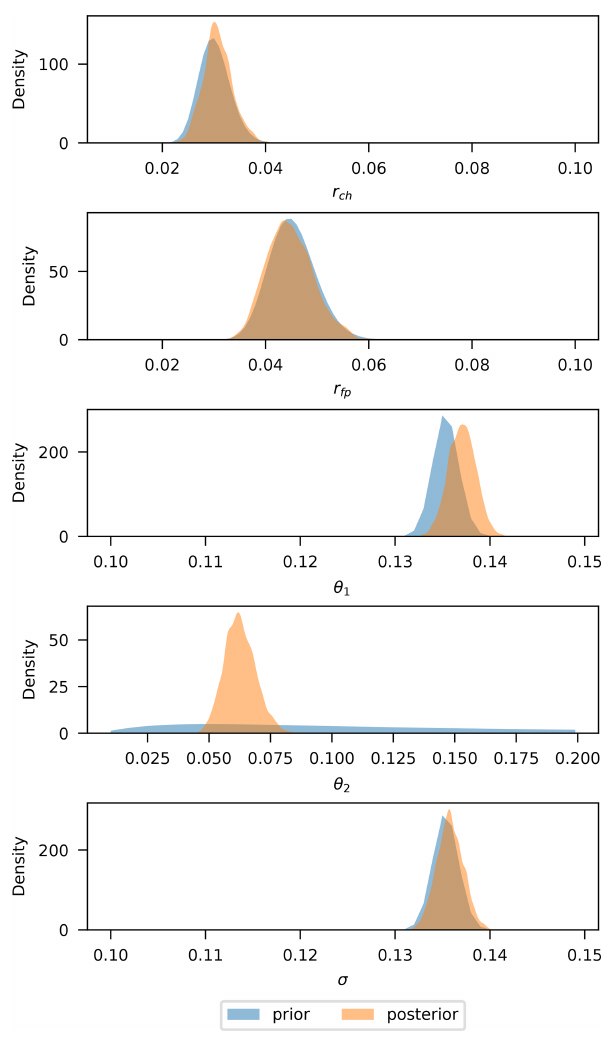
Figure 11. Marginal prior and posterior distributions of parameters.